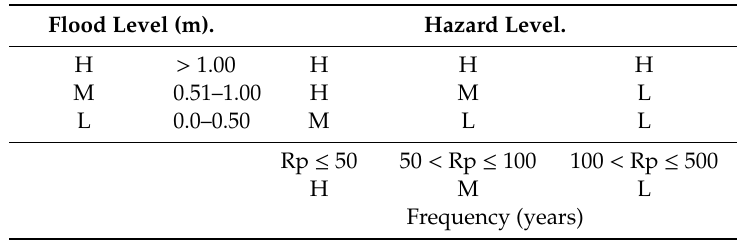
Table 3. Hydrological hazard levels for di ff erent return periods (Rp)*. Flood Level